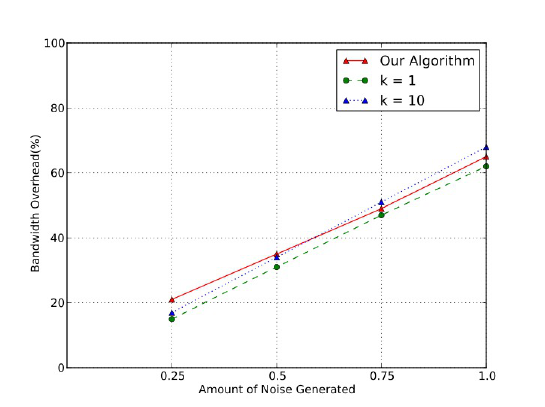
Figure 7. The bandwidth overhead when introducing different kinds of cover